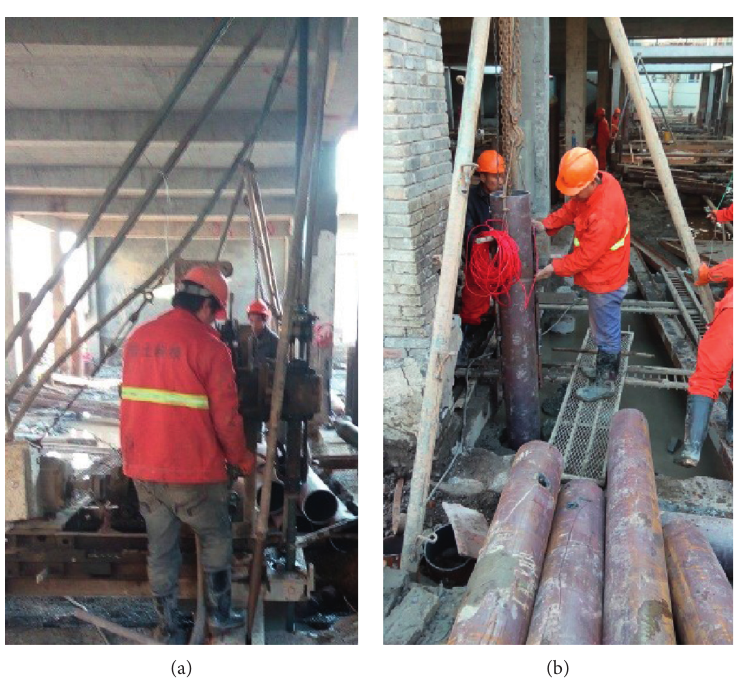
Figure 5: Predrill the steel pipe pile: (a) drill; (b) place down the pipe. Figure 12. The reason may be related to the groundwater level.